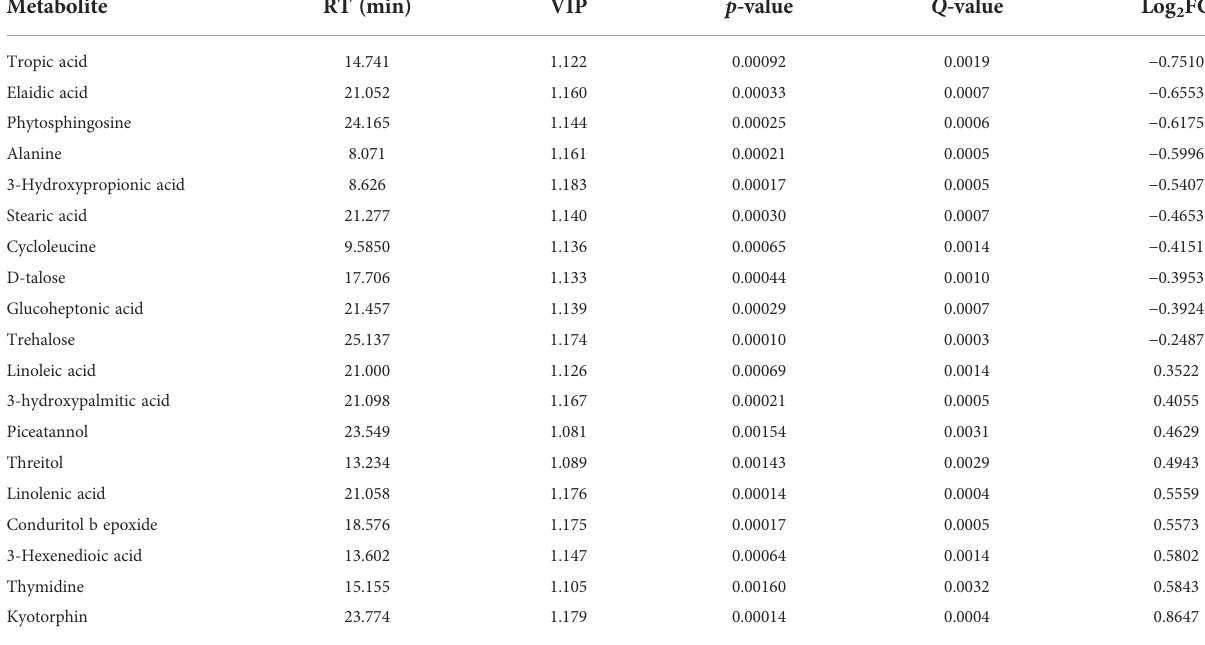
TABLE 2 Identi fi cation results of important